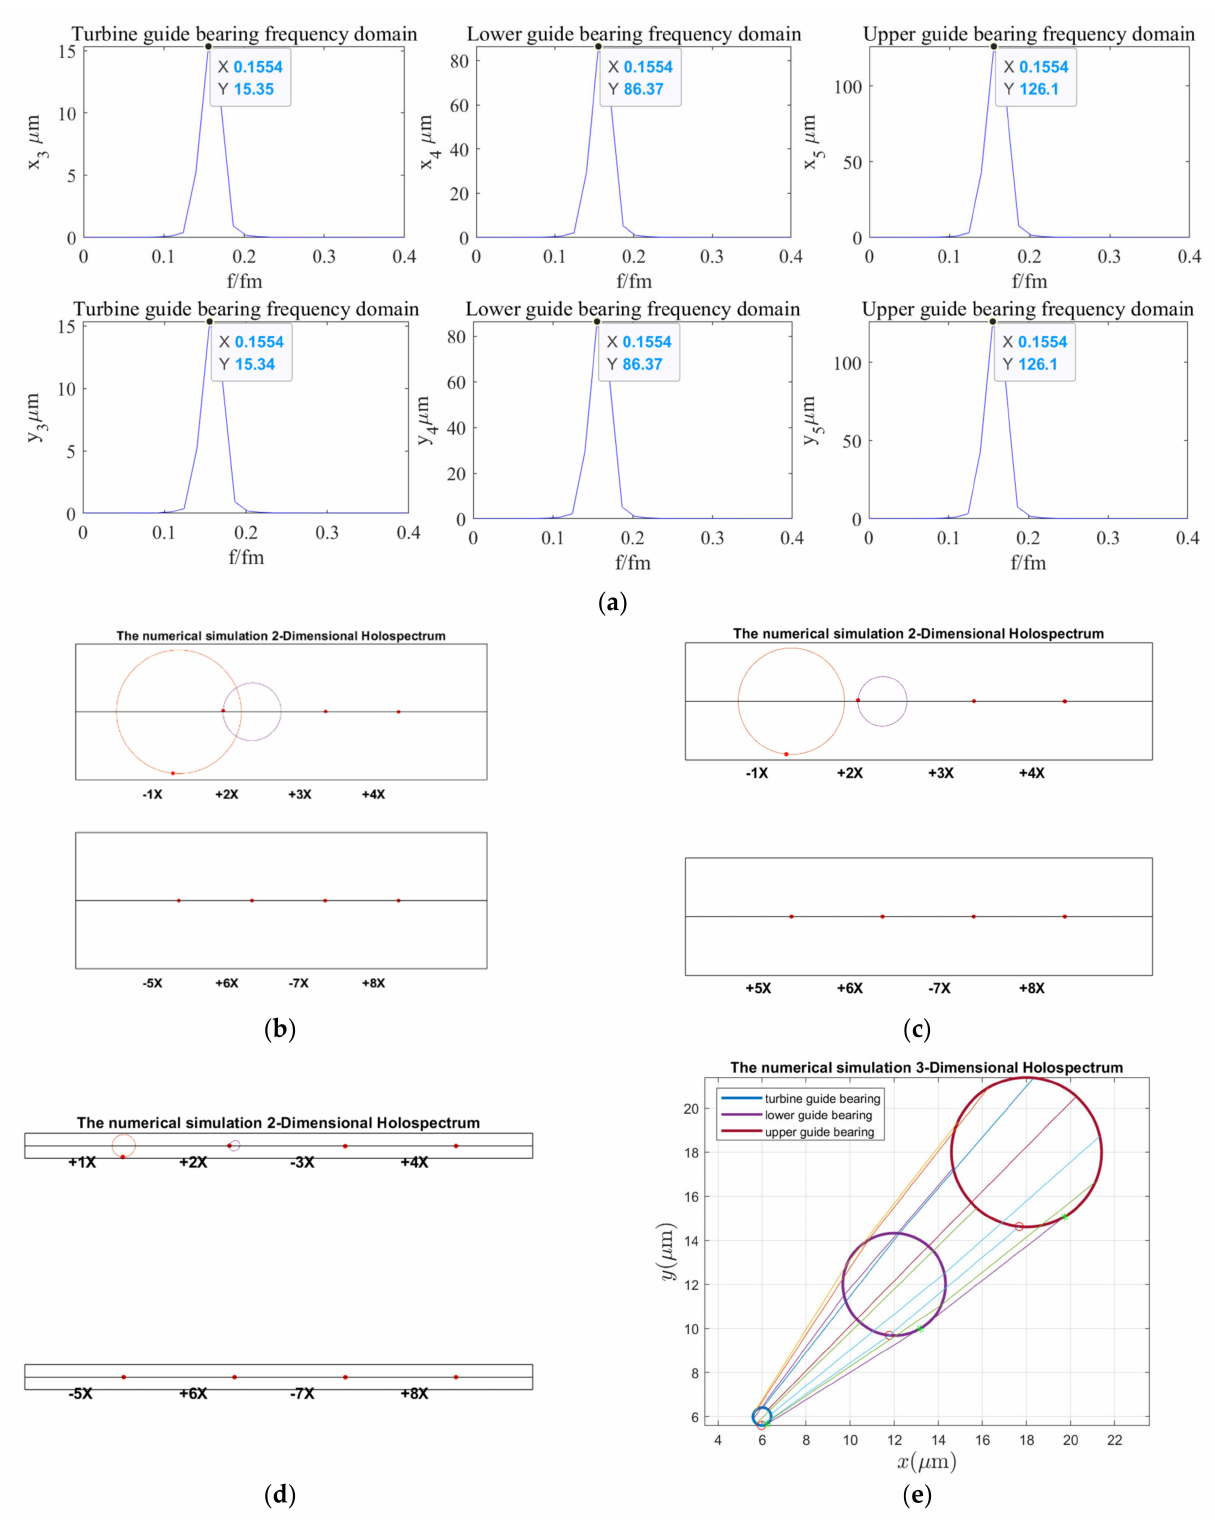
Figure 15. Holospectrum of shafting vibration of misaligned unbalance rotor consider oil film and RAW forces: ( a ) Shafting vibration spectrogram, ( b ) Upper guide bearing 2D holospectrum, ( c ) Lower guide bearing 2D holospectrum, ( d ) Hydro-turbine guide bearing 2D holospectrum, ( e ) One-fold frequency 3D